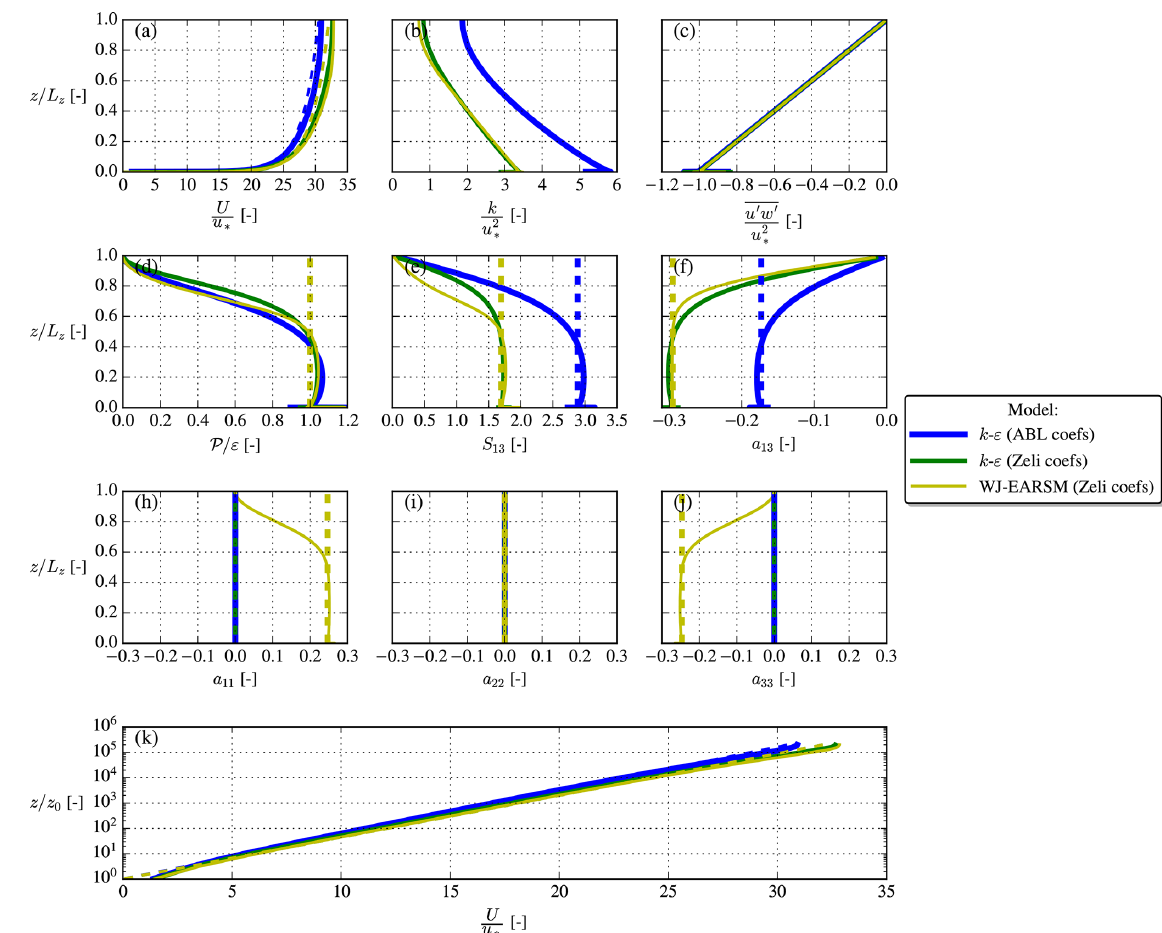
Figure 6. Half-channel simulation results (full lines) and analytical log-layer solutions (dashed lines).